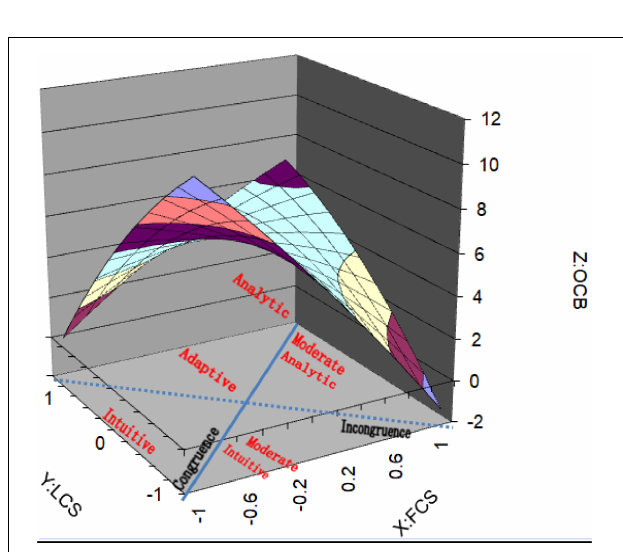
FIGURE 2 | Response surface graph of OCBI.